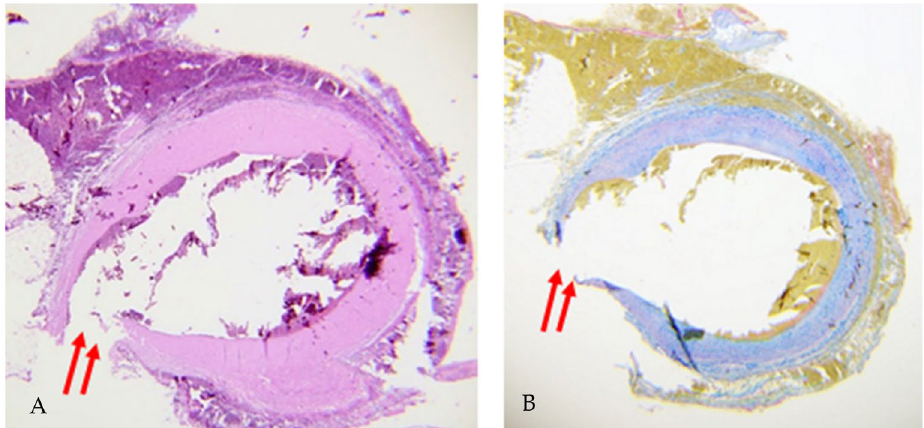
Figure 2. This figure shows two histological preparations, one stained with hematoxylin-eosin ( A ) and the other with trichrome staining. ( B ). Two red arrows indicate the rupture point in the inner and outer layers with partial dislodgement.